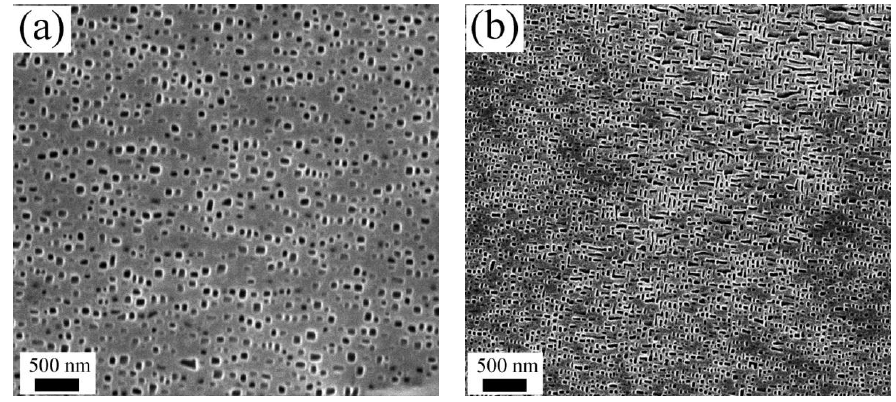
Figure 2. Back-scattering SEM images of: ( a ) Al 0.3 CrFeNiV HEAs; and ( b ) Al 0.5 CrFeNiV HEAs.